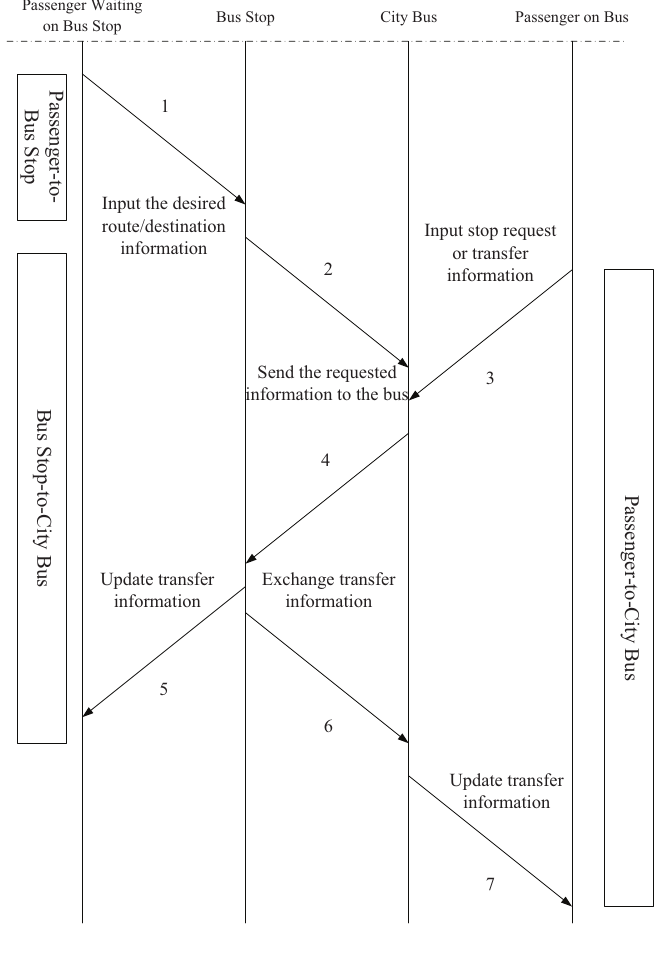
Figure 4. Data transfer sequence of the intelligent bus system model. Table 1. An example of the data frame format